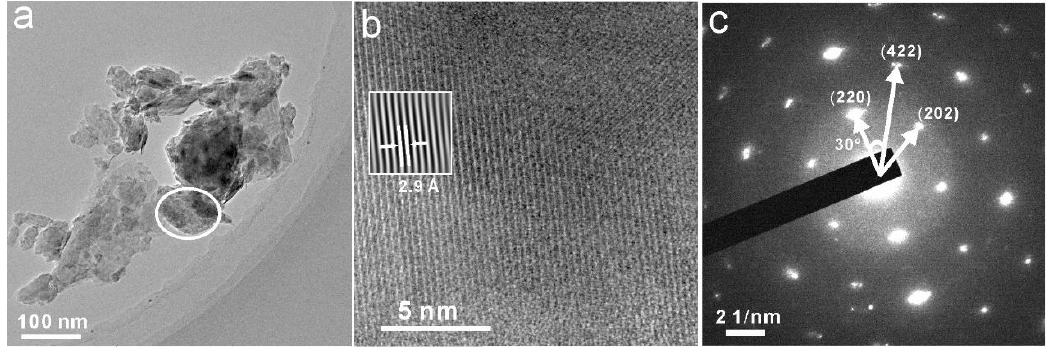
Figure 6. TEM morphology ( a ), lattice photograph ( b ) and selected area electron diffraction pattern ( c ) of magnetite in the soil Fe/Mn coating.